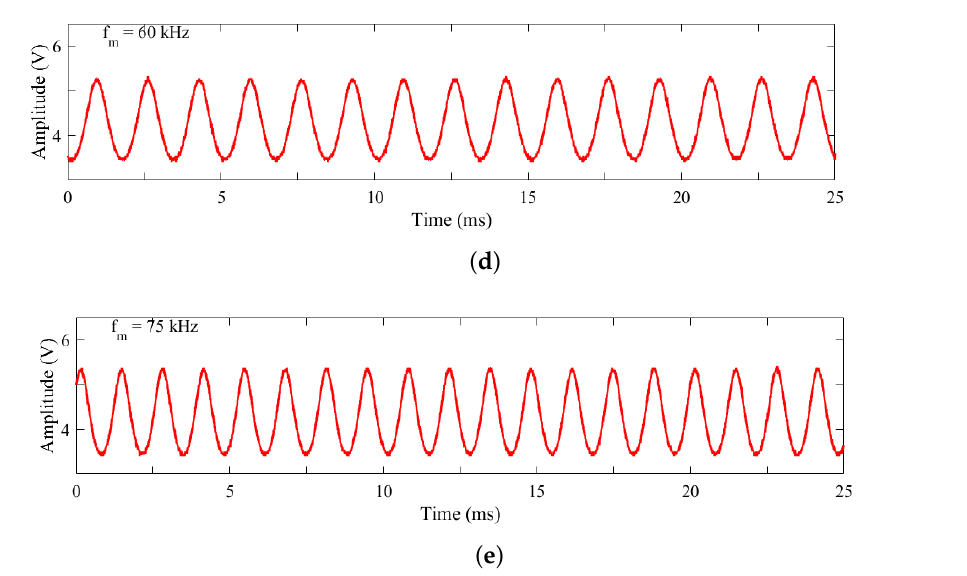
Figure 3. Laser diode emission by varying the harmonic modulation frequency and with fixed amplitude A m = 7.5 V and modulation frequency f m : ( a ) 15 kHz, ( b ) 30 kHz, ( c ) 45 kHz, ( d ) 60 kHz, ( e ) 75 kHz.